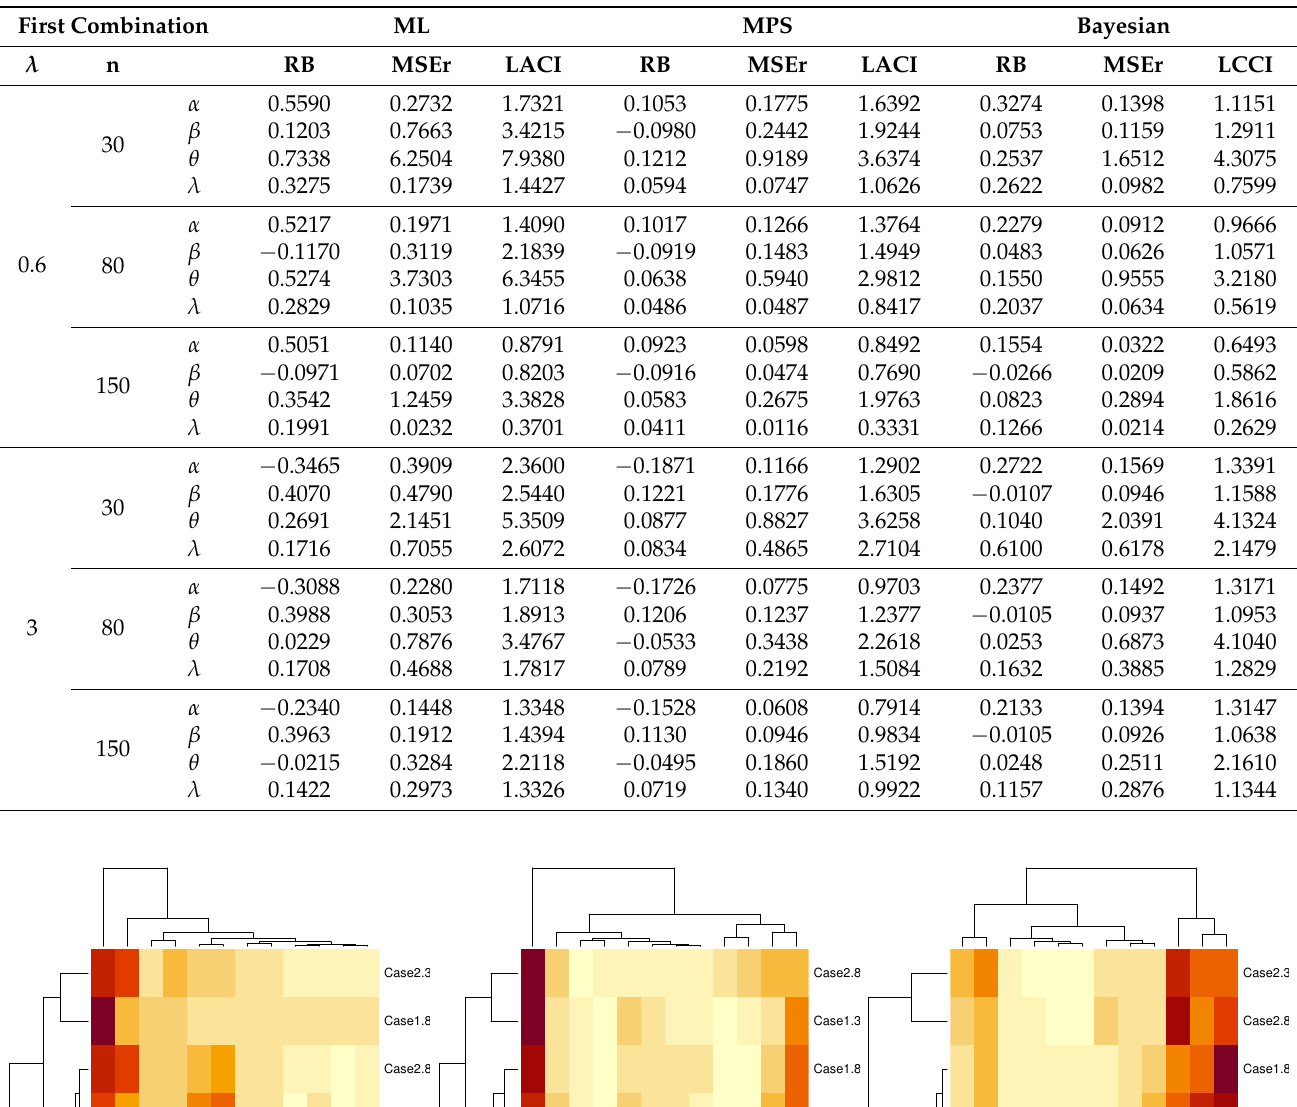
Table 4. ML, MPS, Bayes estimation methods: RB, MSE, LACI and LCCI at first combination.